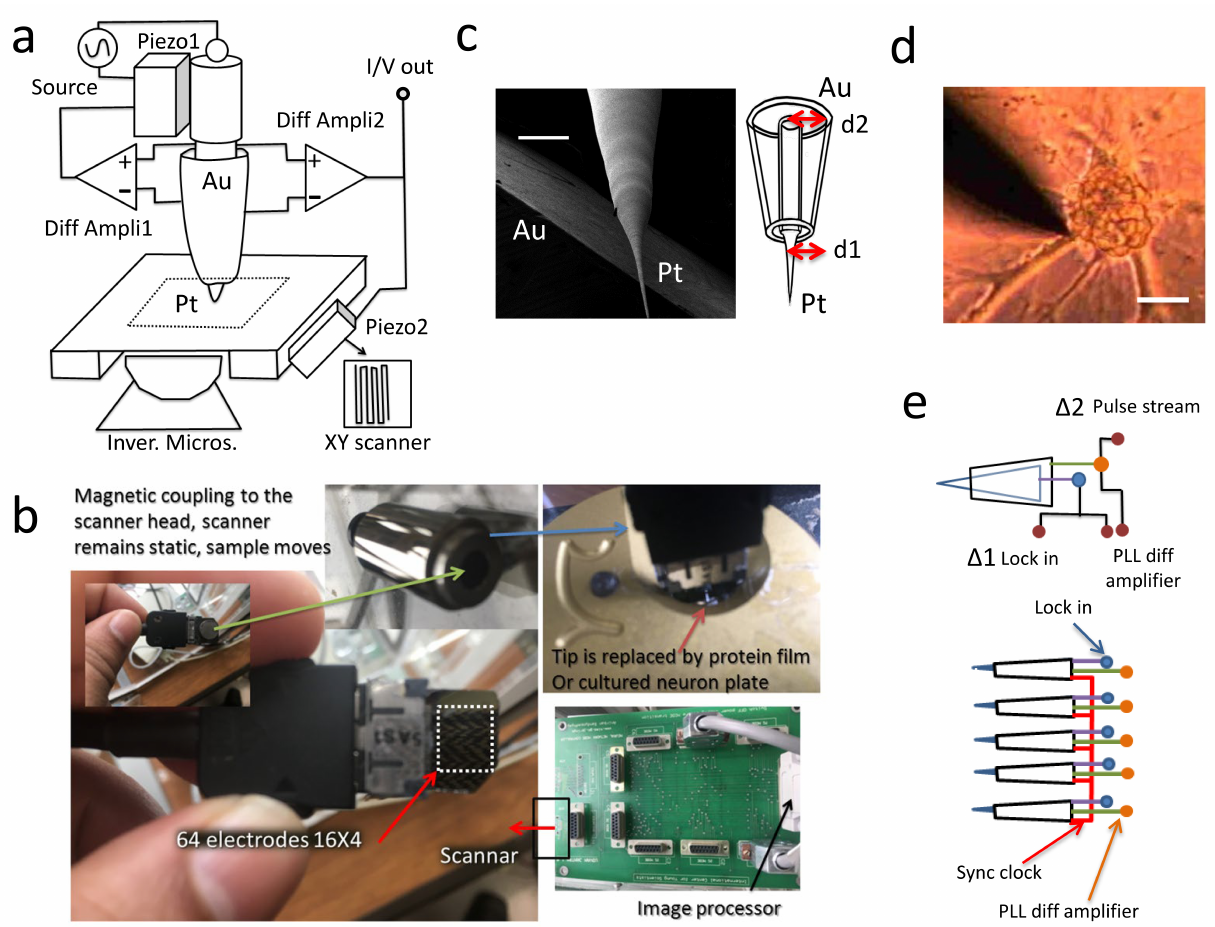
Fig.1. BasicconceptsofSDIMusedintheexperiment. (a) Double piezo scanner (Piezo1, Piezo2) based Scanning Dielectric Ion Microscope (SDIM) set up for high-resolution non-contact imaging of a neuron membrane & its internal structure. Diff. Amp., Differential amplifier; Inv Micro, Inverted Microscope. (b) Basic scanning dielectric microscope SDM, which can perform as SDIM, an easy-to-use nano surf STM, was converted to build 64 grid-based simultaneous pixel data capture hardware. (c) He-ion microscopy of coaxial atom probe and its schematic to the right, scale bar 250 nm (left). Schematic of a coaxial probe. (d) An accurate contact is made to a rat hippocampal neuron using a coaxial probe, scale bar 30 µ m. (e) Coaxial probe measuring circuit connected to one (above) and five coaxial probes. Pulse stream-connected to function generator, PLL diff amplifier-Phase locked loop differential amplifier, Sync periodic oscillation-Synchronized capturing of data sensing & reading by specialized